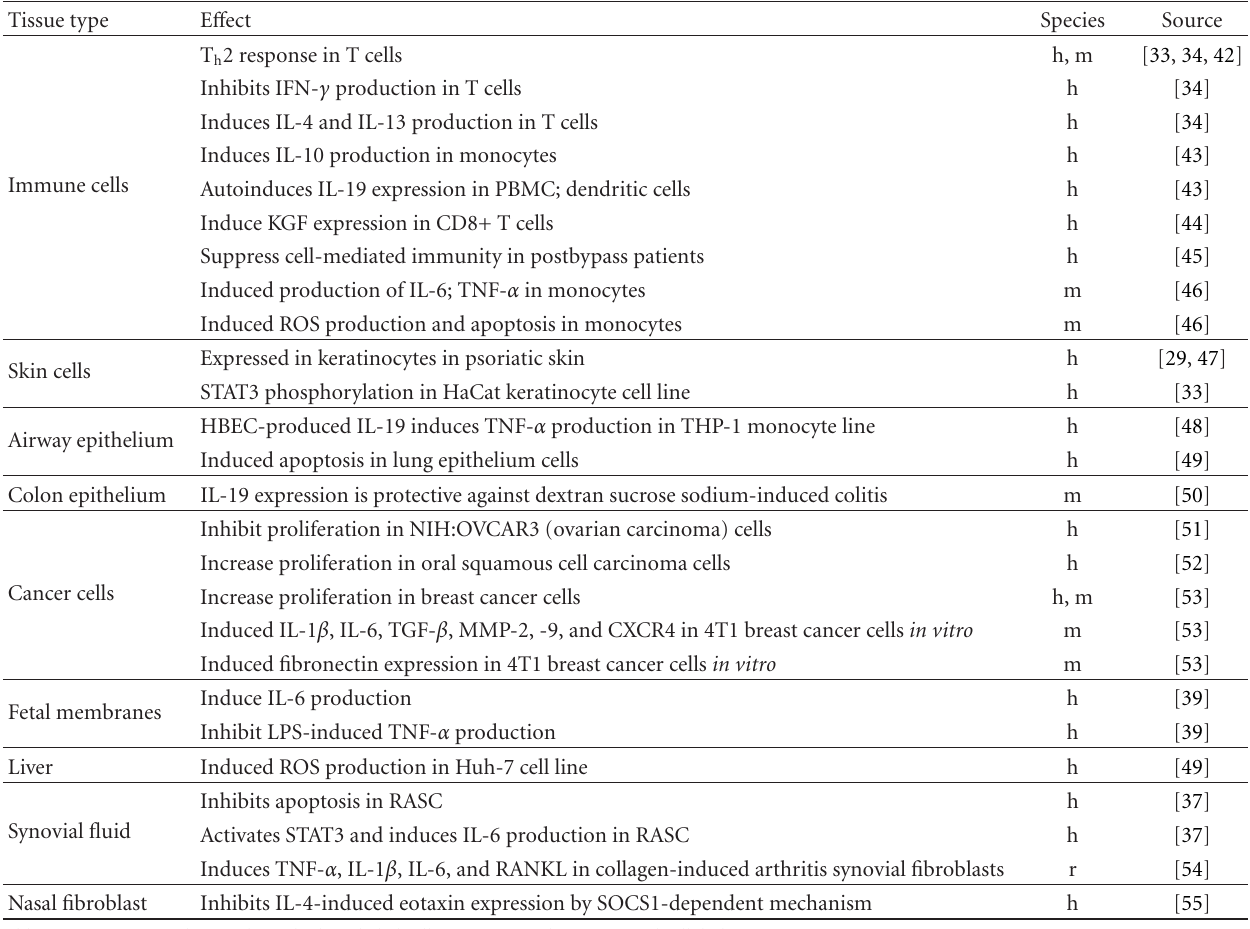
Table 1: E ff ects of IL-19 in nonvascular cell